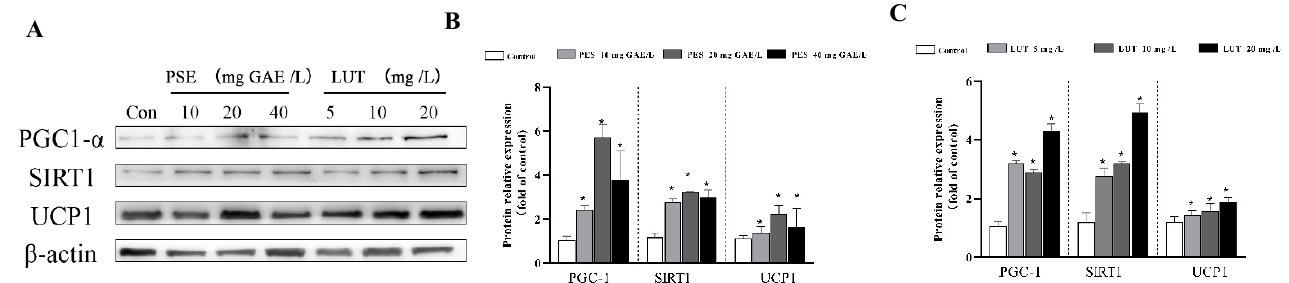
Figure 10. PSE and LUT modulated the expression of core browning protein markers. ( A ) Western blot results for the browning proteins. The quantification of PGC1 － α , SIRT1, UCP1 after ( B ) PSE and ( C ) LUT treatment. The data are presented as the mean ± SD from three independent experiments. * Significant differences are indicated by p < 0.05.